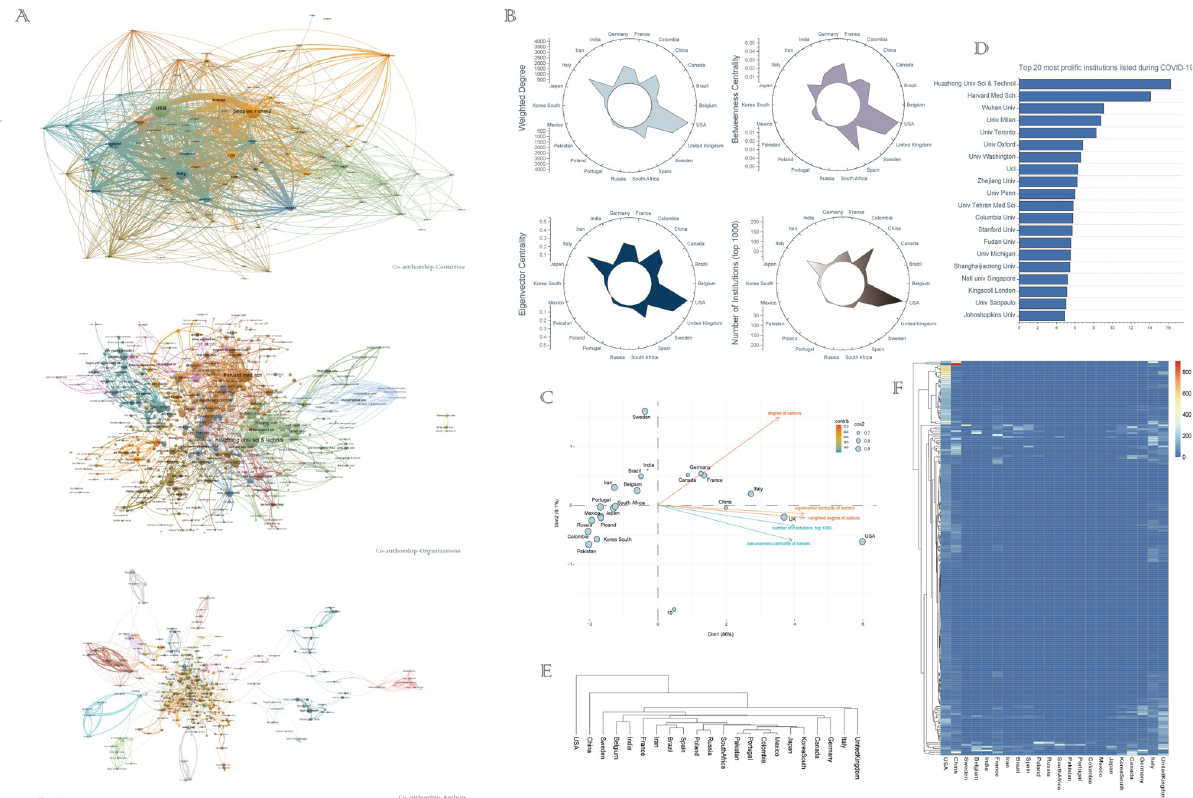
Fig 2. Big data analysis and data visualization reveal the current situation of international scientific collaboration during the COVID-19 period. (A) International collaboration map of the COVID-19 research during the COVID-19 period. Upper panel: co-authorship network of countries; middle panel: co-authorship network of institutes; lower panel: co-authorship network of locations. (B-C) Circos map and PCA analysis of international collaboration networks in 22 nations during the COVID-19 period. (D) The top 20 most prolific institutions listed during COVID-19. (E-F) Unsupervised hierarchical clustering and heatmap displaying of the performance of all institutions in selected 22 nations.